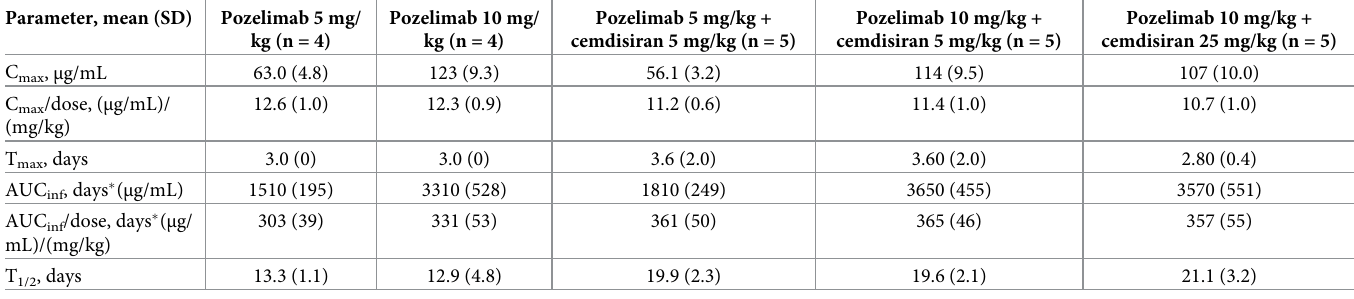
AUC, area under concentration-time curve; AUC inf , AUC from time zero extrapolated to infinity; C max , peak concentration; d, day; n, number of animals per group; SD, standard deviation; T 1/2 , elimination half-life; T max , time to C max . � Concentration values considered by the investigator to be outliers were excluded for all animals from Groups 5–7 at Day 78. Concentration values considered by the study investigator to be impacted by anti-drug antibodies were excluded (n = 1 in the pozelimab 10 mg/kg